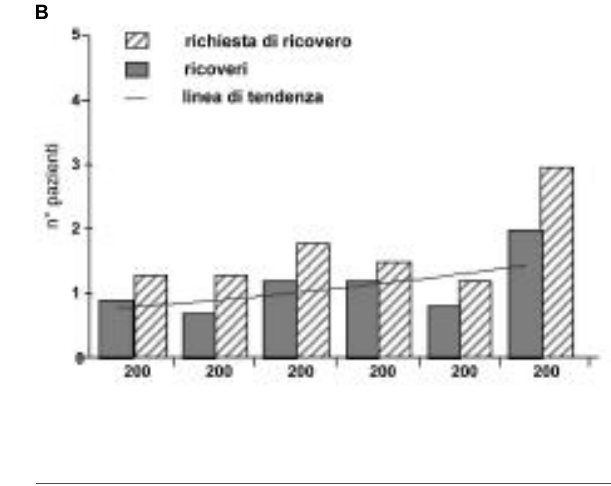
Figura 2. (A) Numero di pazienti stranieri riferiti all’IGG. (B) Numero di pazienti stranieri non romeni riferiti all’IGG. (C) Numero di pazienti romeni riferiti